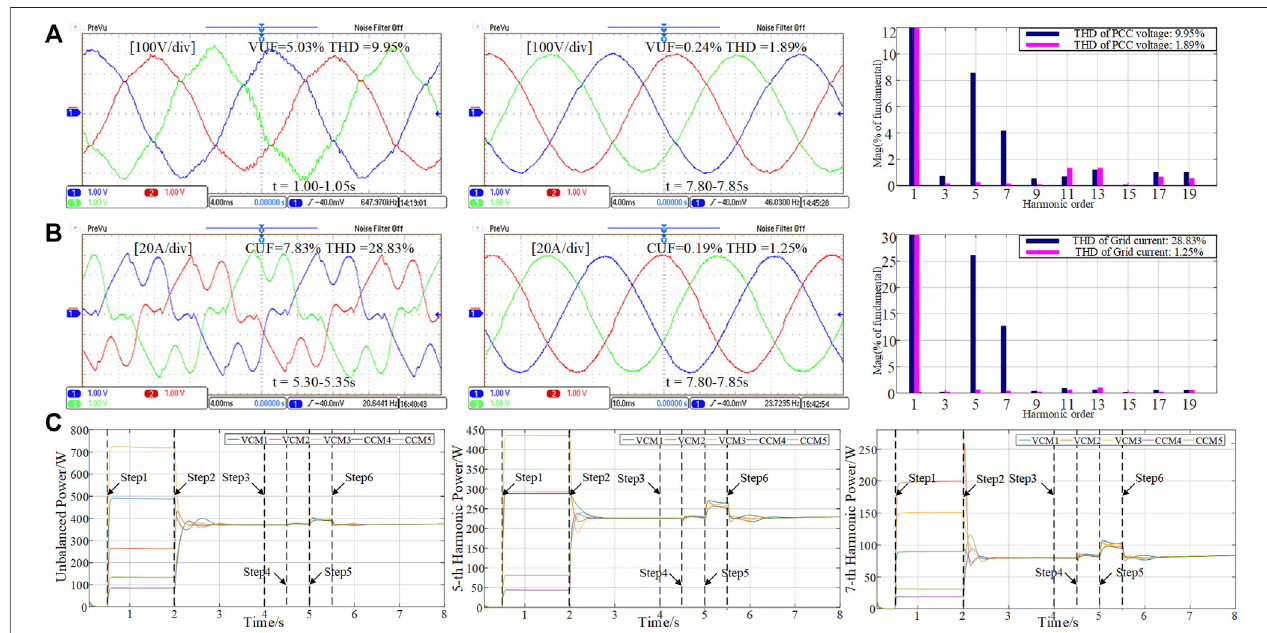
FIGURE 13 | Simulation results of proposed control with unbalanced and harmonic voltage on the main grid side. (A) Harmonic and unbalanced voltage at PCC andTHDofvoltageatdifferenttimes. (B) Harmonicandunbalancedgrid-connectedcurrentandTHDofcurrentatdifferenttimes. (C) Powerperformanceofunbalanced 5th and 7th harmonic